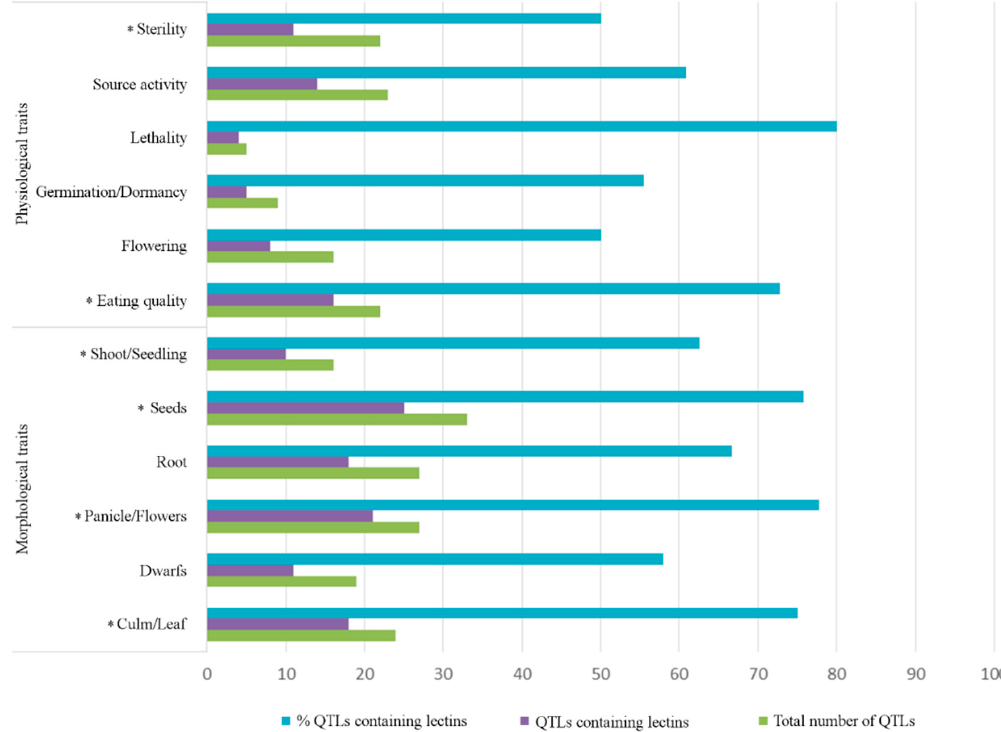
Figure 3. The total number of QTLs for morphological and physiological traits, number of QTLs for morphological and physiological traits containing lectin sequences, and percentage of QTLs for morphological and physiological traits containing lectin sequences. The asterisks refer to a statistically significant overrepresentation ( p < 0.001) of lectin sequences in QTLs for the